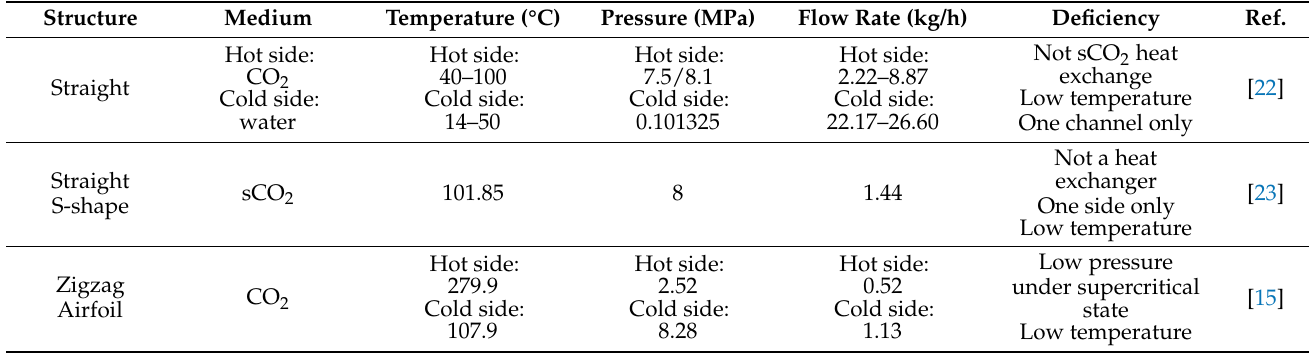
Table 2. Numerical simulation research on the thermal–hydraulic performance of PCHE.